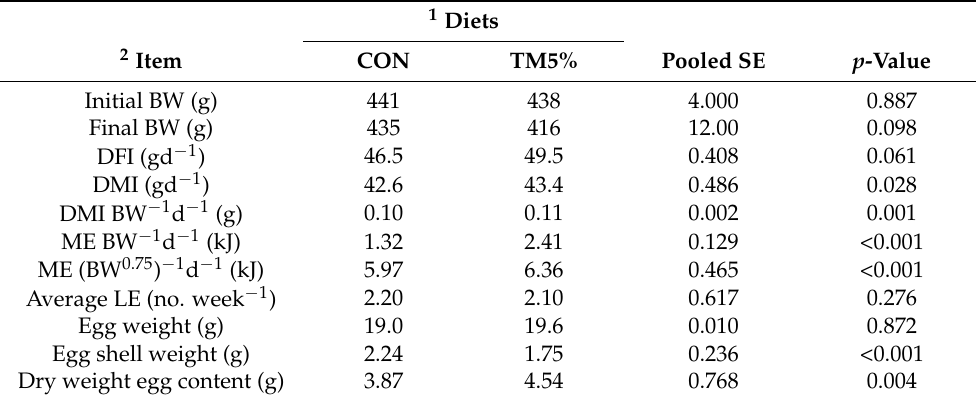
Table 2. Birds’ performance in the two feeding groups (CON vs. TM5%).